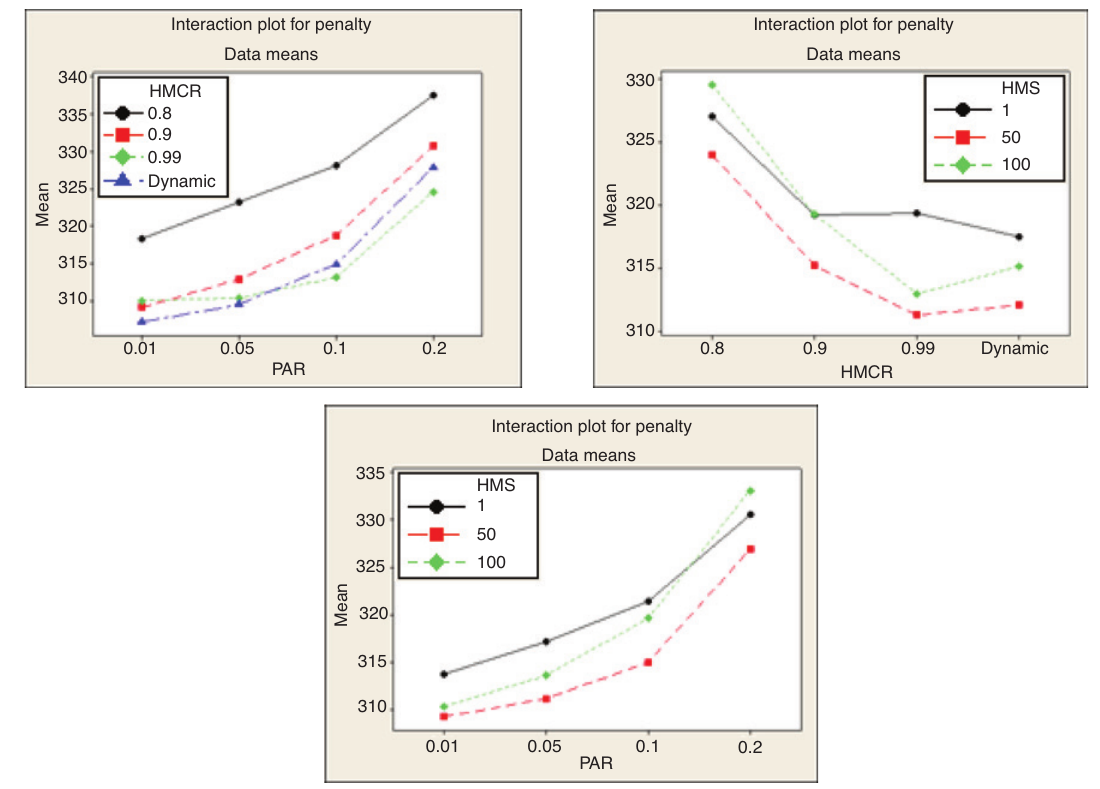
Figure 3: Interaction Plots of Main